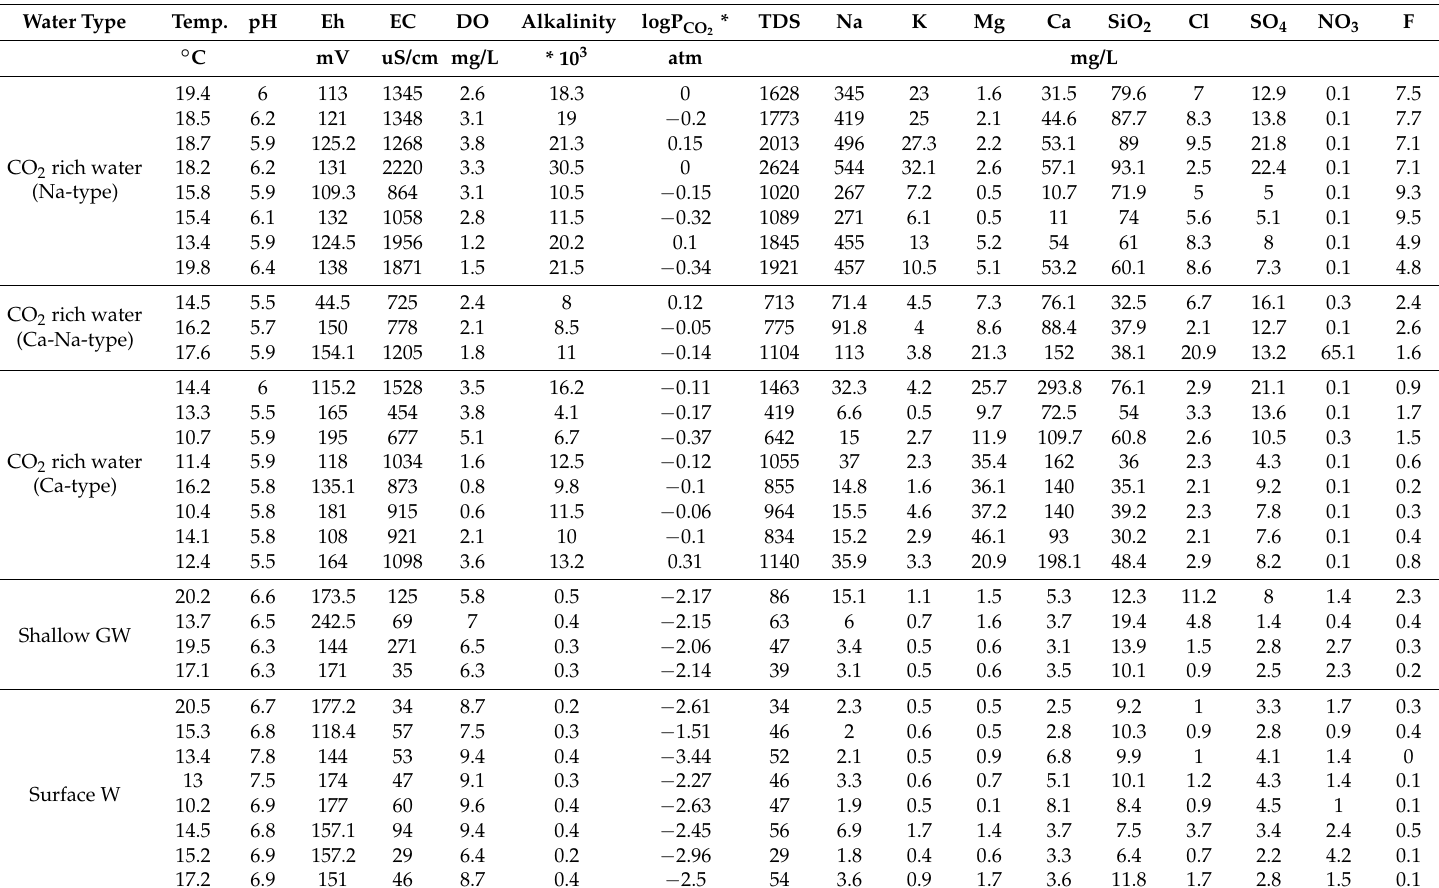
Table 3. Geochemical data of water samples from Gangwon Province